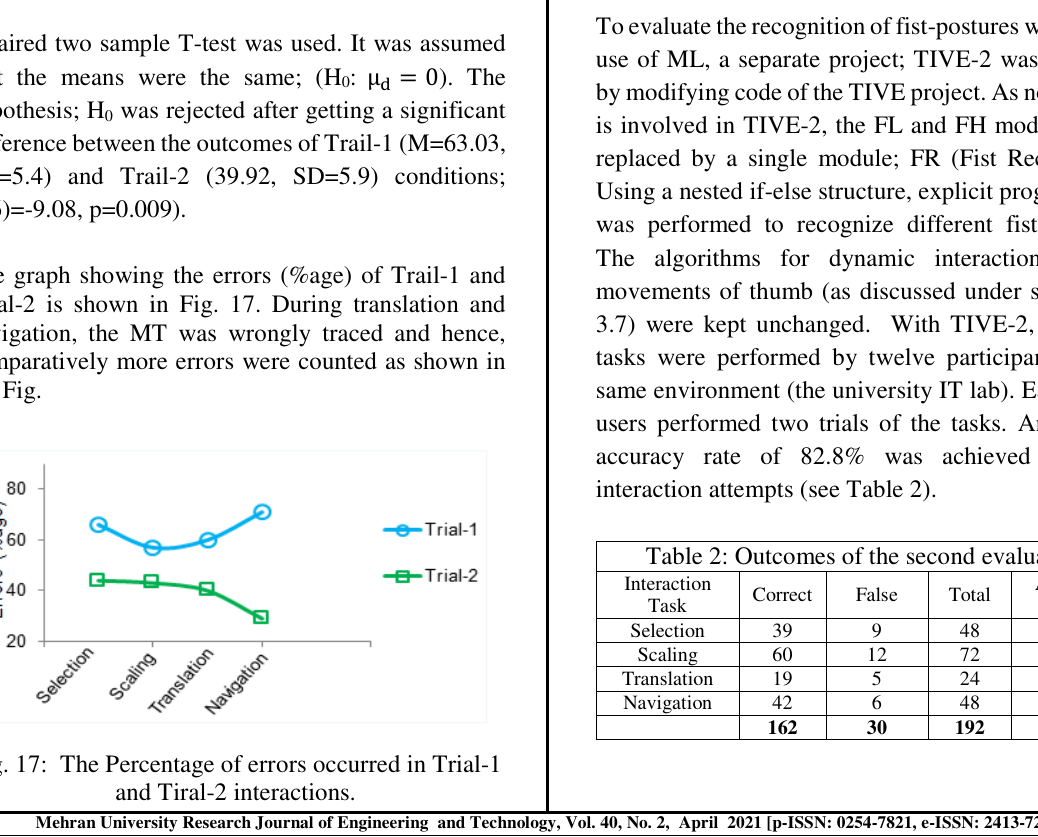
Fig. 16: Mean of the Percentage Accuracy of the two trials